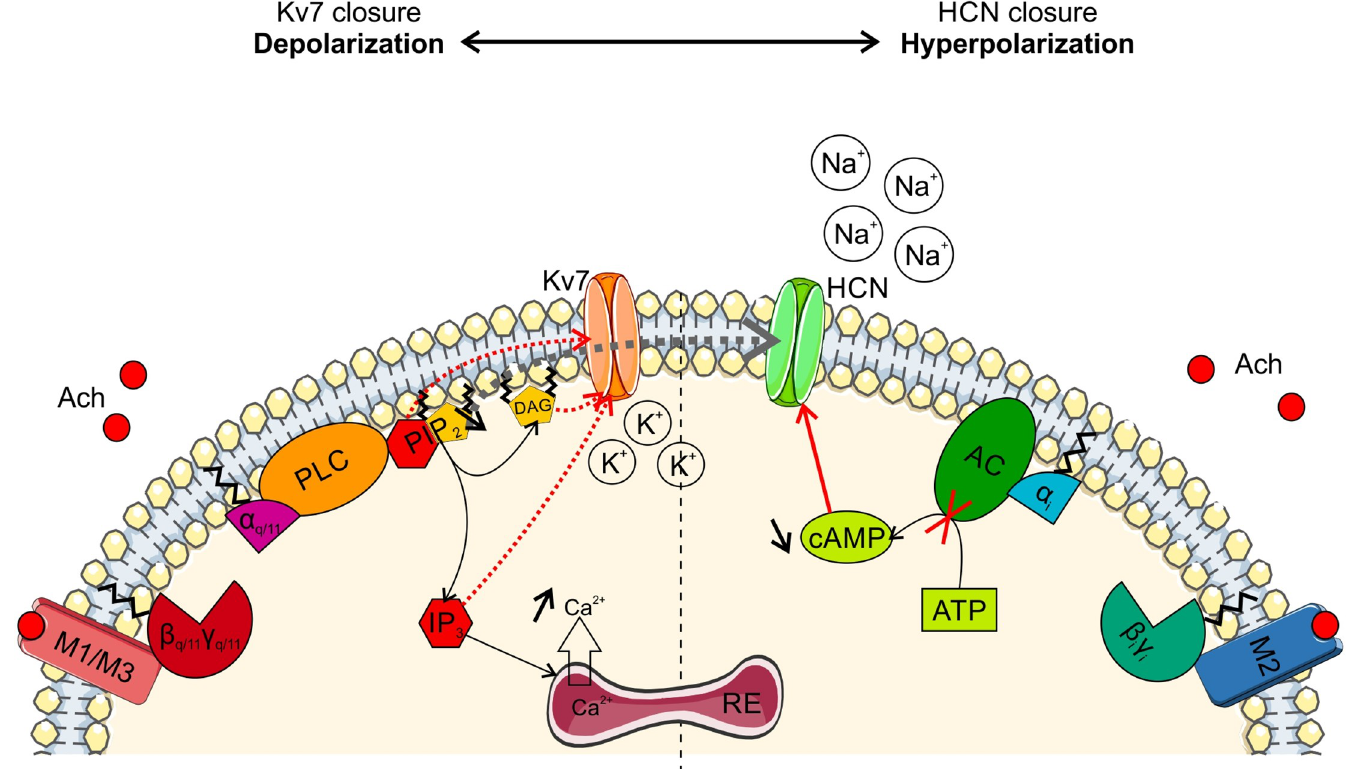
Fig 11. Hypothetical signaling cascade in response to acetylcholine release. On one hand, acetylcholine (Ach) binds the M1/M3 muscarinic receptor which induces the activation of the phospholipase C (PLC) via the G α q/11 protein. The activated PLC depletes the phosphatidylinositol biphosphate (PIP 2 ) into diacylglycerol (DAG) and inositol triphosphate (IP 3 ). IP 3 concentration increase releases calcium from the internal cell storage. Directly or indirectly, one or several of these 2 nd messengers trigger the closure of Kv7 channels thereby depolarizing the cell membrane. On the other hand, acetylcholine may bind the M2 muscarinic receptor inhibiting the adenylate cyclase (AC) via the G α i protein which induces a reduction of cyclic AMP. Thus, for the same membrane potential, more HCN channels are closed inducing the hyperpolarization of the cell. Cell membrane and ion channels were designed by “Servier Medical Art” (https://smart.servier.com) provided by Les Laboratoires Servier (https://servier.com/en), licensed under Creative Commons Attribution 3.0 Unported License.